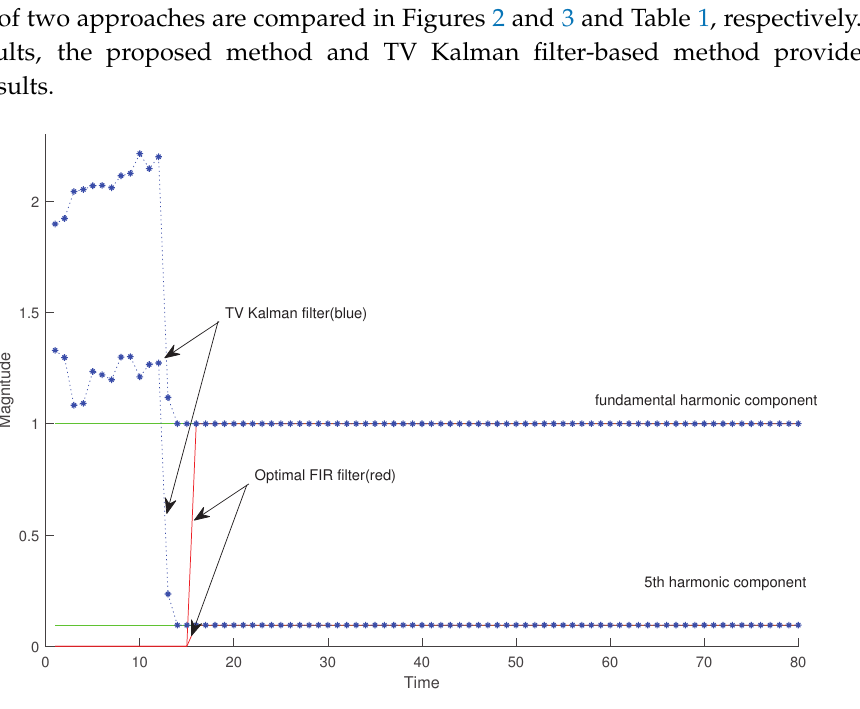
Figure 2. Estimated magnitude of fundamental and fifth harmonic components. TV, time-varying.